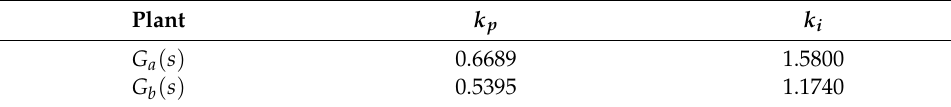
Table 3. PI controller parameters for φ m = 60 ◦ and ω gc = 5 rad/s.